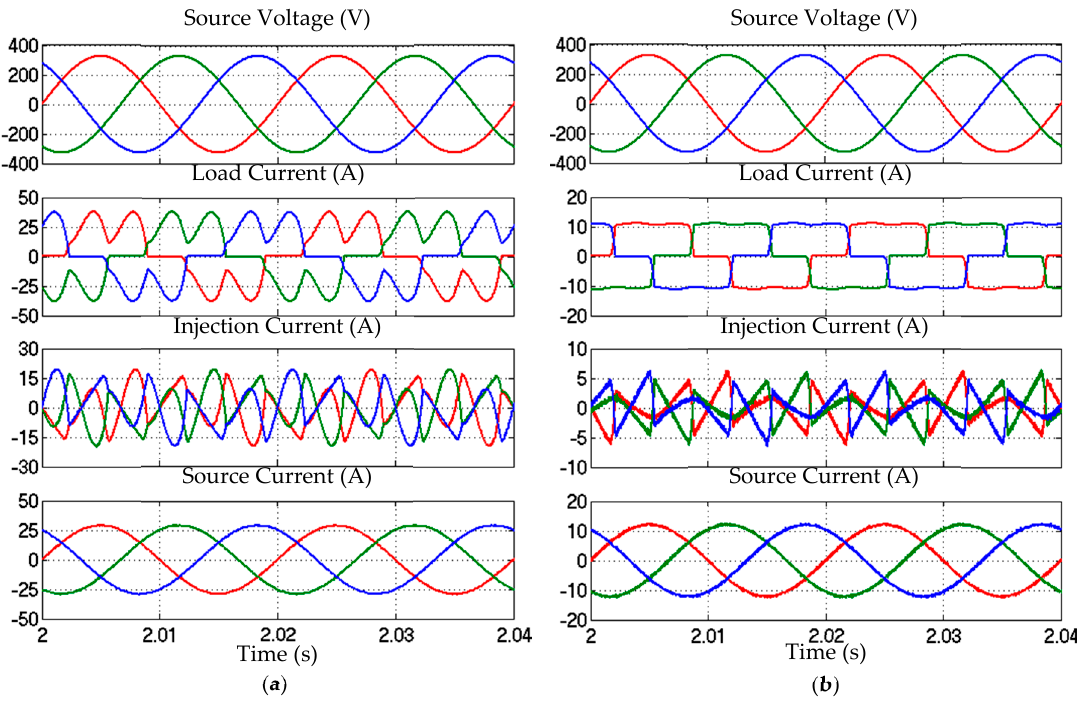
Figure 5. Simulation result showing the three-phase source voltage v Sabc , load current i Labc , injection current i injabc , and source current i Sabc , demonstrated by SAPF utilizing the proposed dual-function pq theory algorithm for: ( a ) capacitive load; and ( b ) inductive load. Table 1. Simulation result showing THD values of source current demonstrated by SAPF while applying its respective reference current generation algorithm, for capacitive and inductive loads.